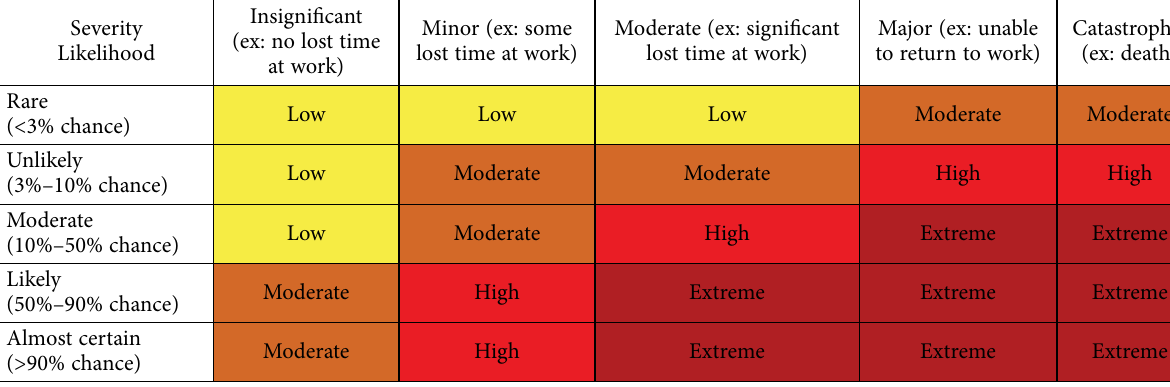
Figure 1. Example of a qualitative risk matrix (Collins et al., 2014)